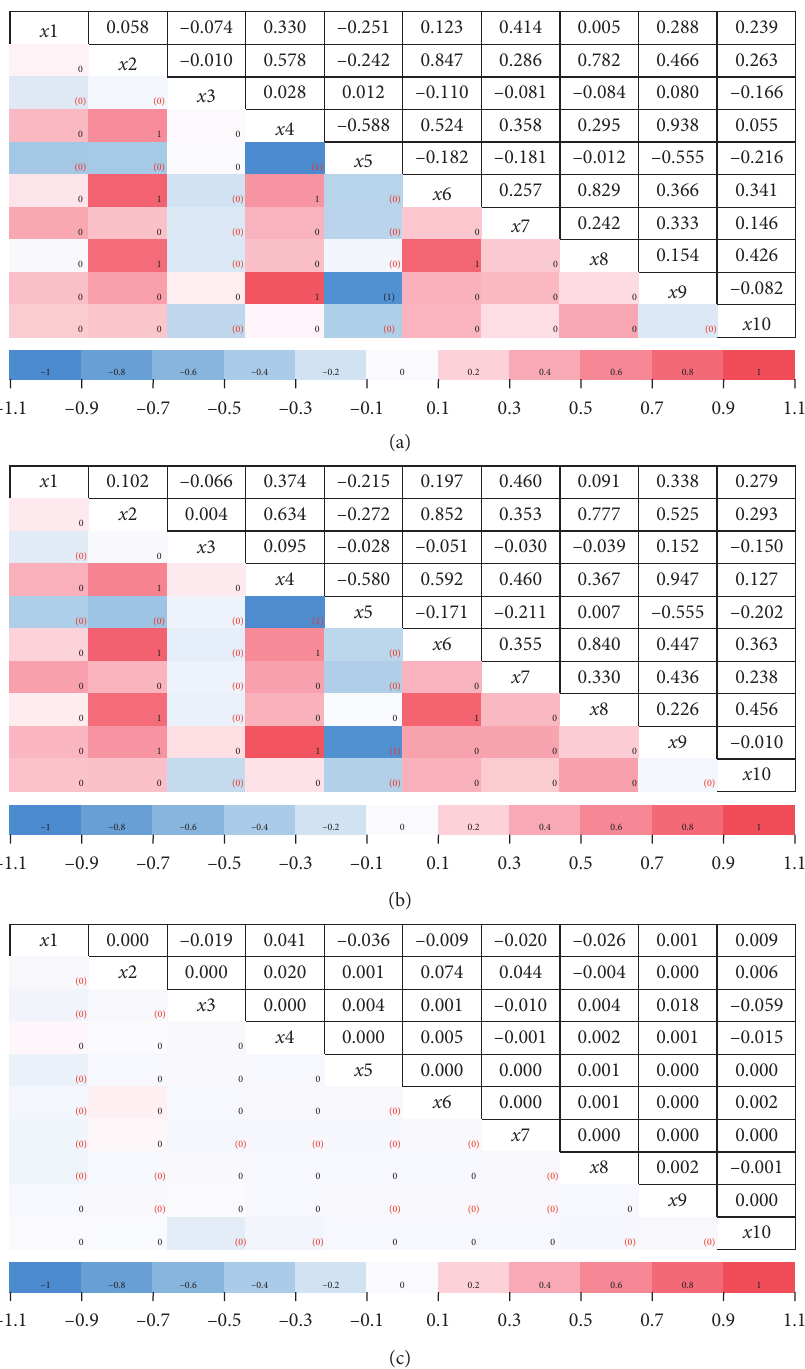
Figure 9: The PCCs of samples from BIM-BDP data, LHS, and eFASTmethod. Colors of the grid cells in the lower-left corner represent the PCCs, and numbers in the upper right represent their specific values: (a) PCCs of samples from BIM-DMSCC system; (b) PCCs of samples from LHS; (c) PCCs of samples from eFAST